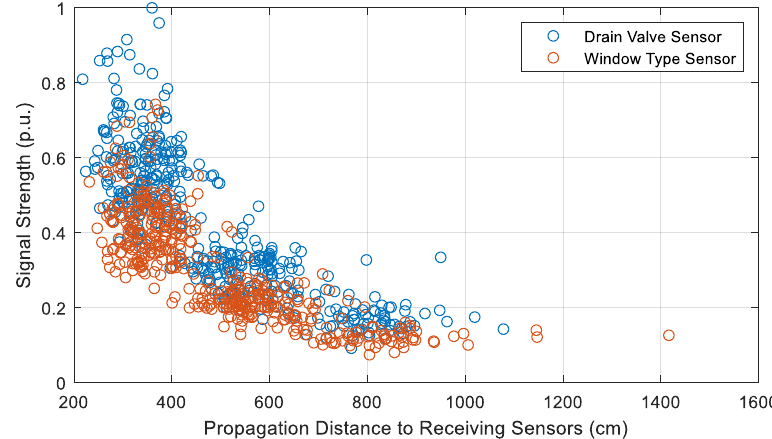
Figure 15. Comparison of the attenuation characteristics of the two sensor designs across different propagation distances.